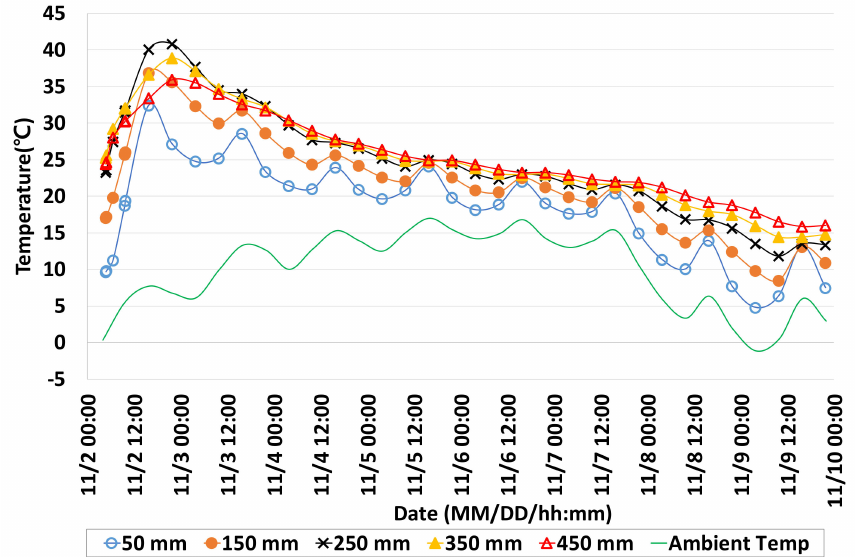
Figure 9. Ambient and concrete temperature for the first seven